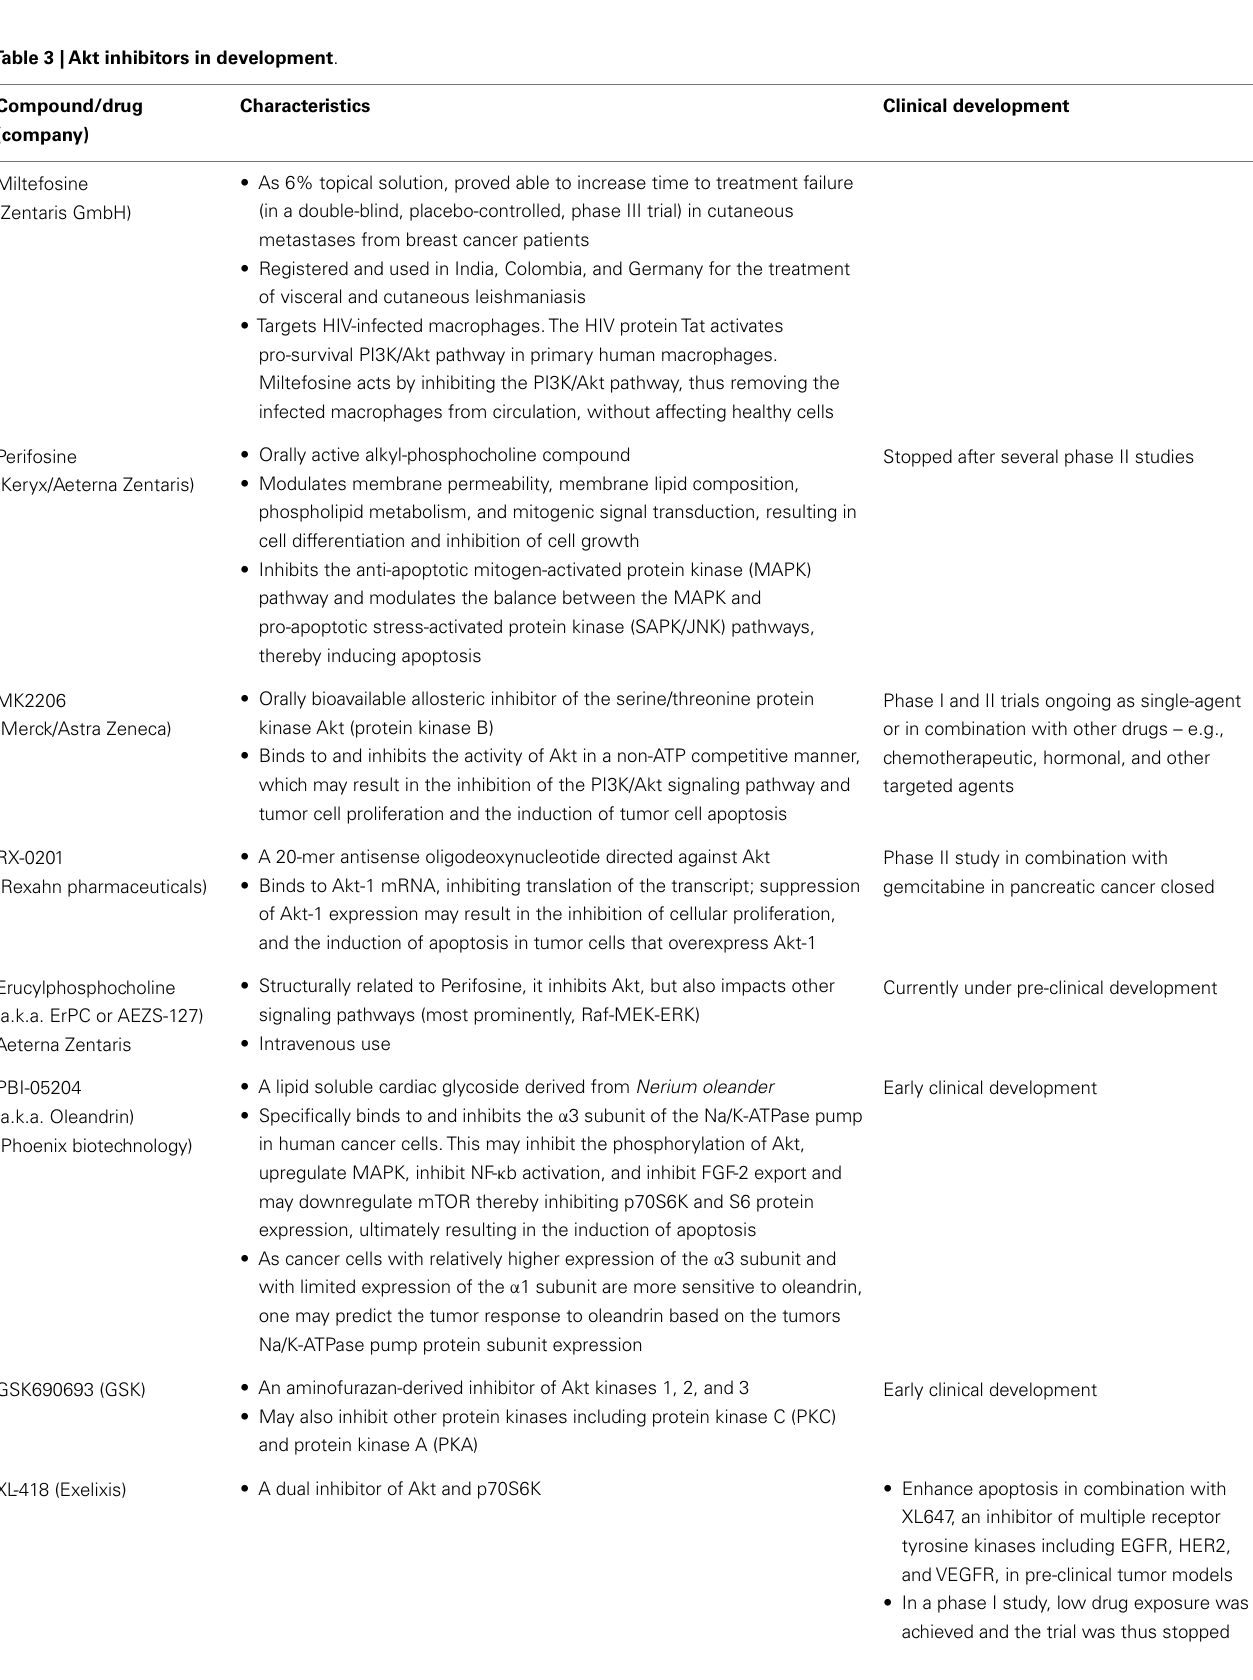
Table 3 |Akt inhibitors in development